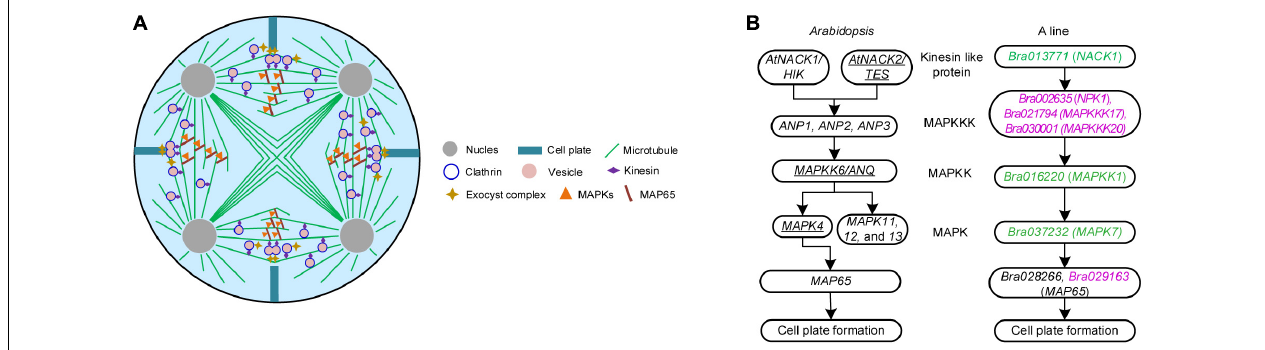
FIGURE 3 | Pathways concerning meiosis cytokinesis in Brassica campestris . (A) Schematic diagram of simultaneous-type plant male cytokinesis. (B) Mitogen-activated protein kinase signaling cascade mediating de novo cell plate formation in Arabidopsis and the genic male-sterile line ‘ Bcajh97-01A ’ (A line) of B. campestris . The left was adapted from De Storme and Geelen (2013) and the right was a putative pathway hypothesized in this study. Underlined genes have been proved to function in male meiotic cytokinesis. Differentially expressed genes down and upregulated were colored in green and rose red, respectively. B line, the fertile line ‘ Bcajh97-01B ’; A line, the genic male-sterile line ‘ Bcajh97-01A ’; MAPKK, MAPK kinase; MAPKKK, MAPKK kinase; NACK1/2, Nicotiana protein kinase 1 (NPK1)-activating kinesin 1; HIK, hinkel; TES, tetraspore; ANP1/2/3, Arabidopsis NPK1-related protein kinase 1/2/3; ANQ, Arabidopsis Nicotiana kinase next to NPK1